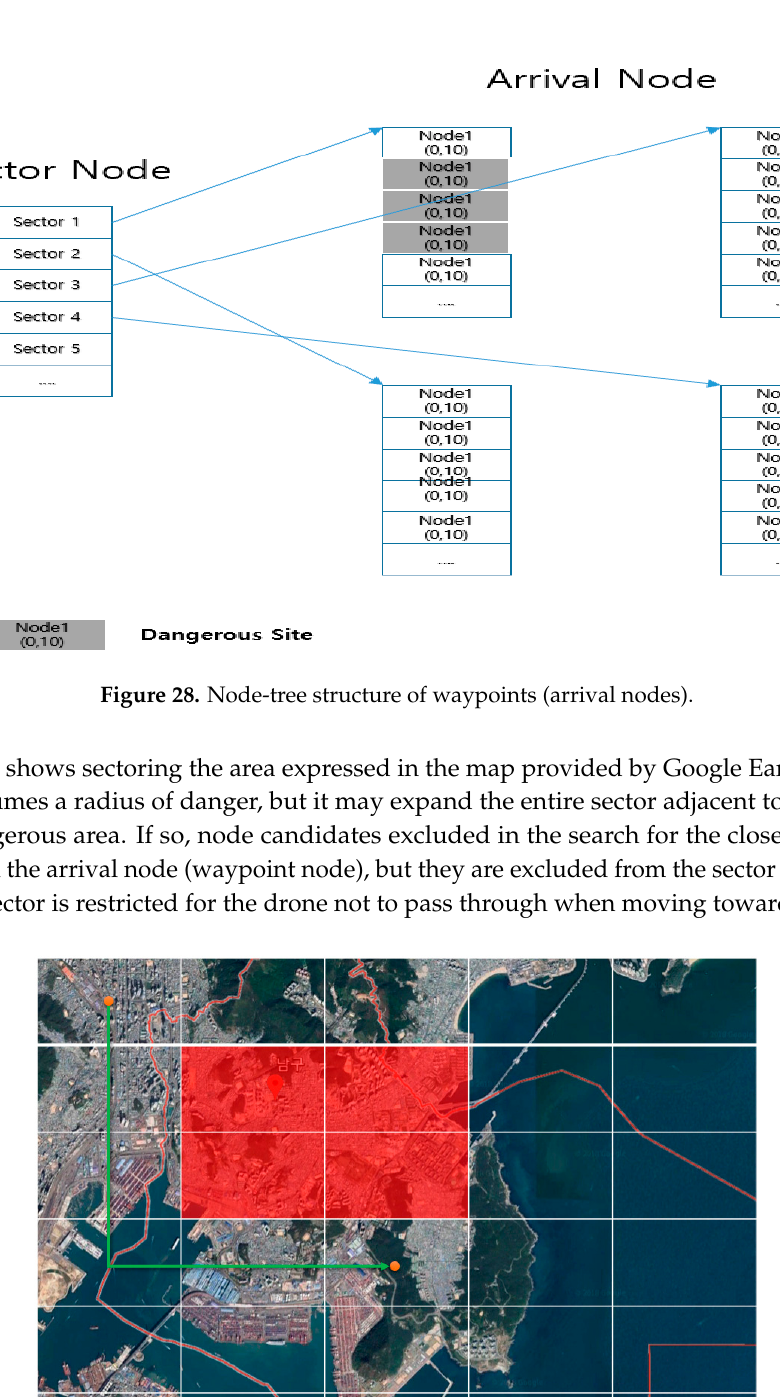
Figure 30. Sector subject to search according to the sectoring waypoint.